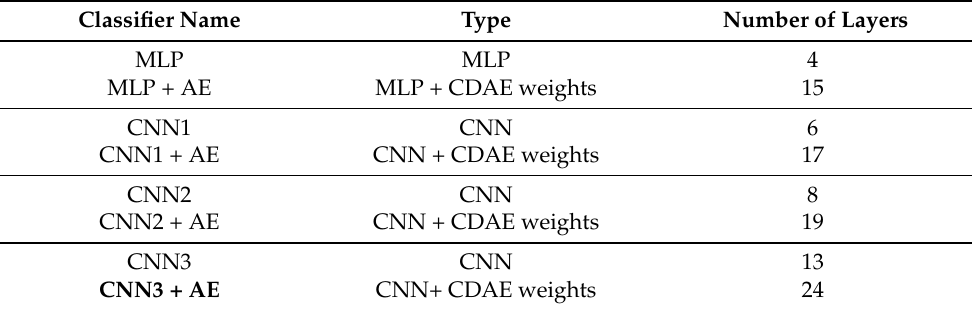
Table 2. Classifier configurations. The proposed classifier architecture is